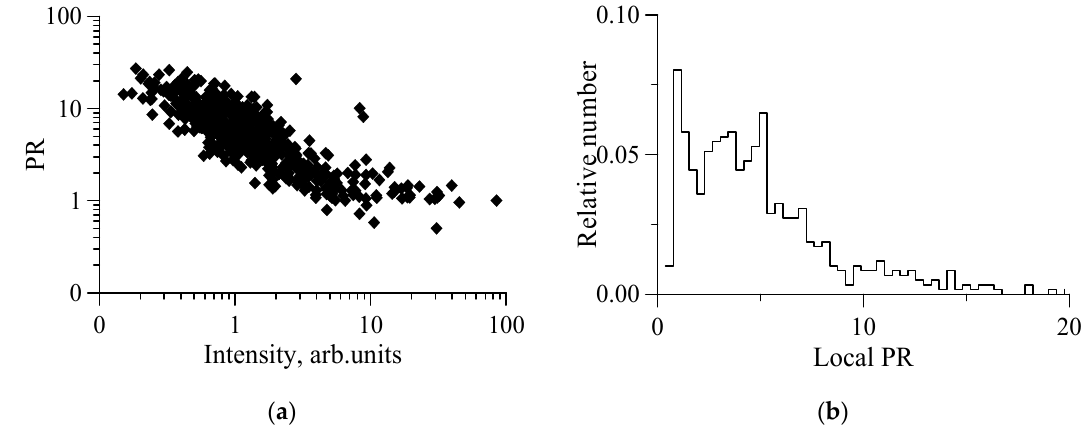
Figure 7. A scatterplot of polarization ratios vs. radar return intensity at HH polarization ( a ) and a histogram of polarization ratio values ( b ).